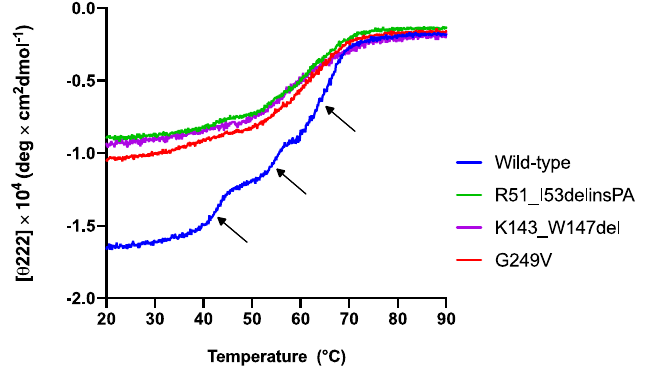
Figure 3. Thermal unfolding profiles of wild-type and mutant MBP–CHIP proteins monitored by circular dichroism spectroscopy. Thermal unfolding curves were obtained for MBP–CHIP proteins by following changes in molar ellipticity at 222 nm wavelength as a function of temperature. Wild- type MBP–CHIP shows three distinct transitions at approximately 42.8 °C, 54.6 °C, and 65.1 °C, as indicated by arrows, whereas all three variants show loss in both ellipticity and transitions.